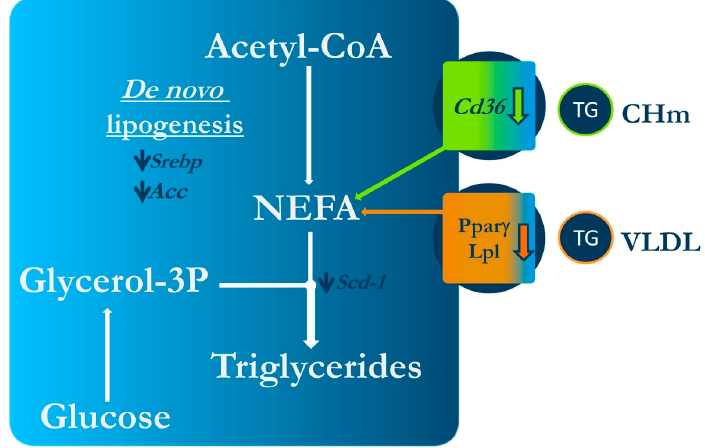
Figure 5. Mechanism of action underlying the effect of isorhamnetin on obesity in rodents. Acc: acetyl-CoA carboxylase; Cd36: cluster of differentiation 36; CHm; Chylomicrons; Lpl: lipoprotein lipase; NEFA: non-sterified fatty acids; PPAR γ : peroxisomal proliferator-activated receptor γ ; Scd-